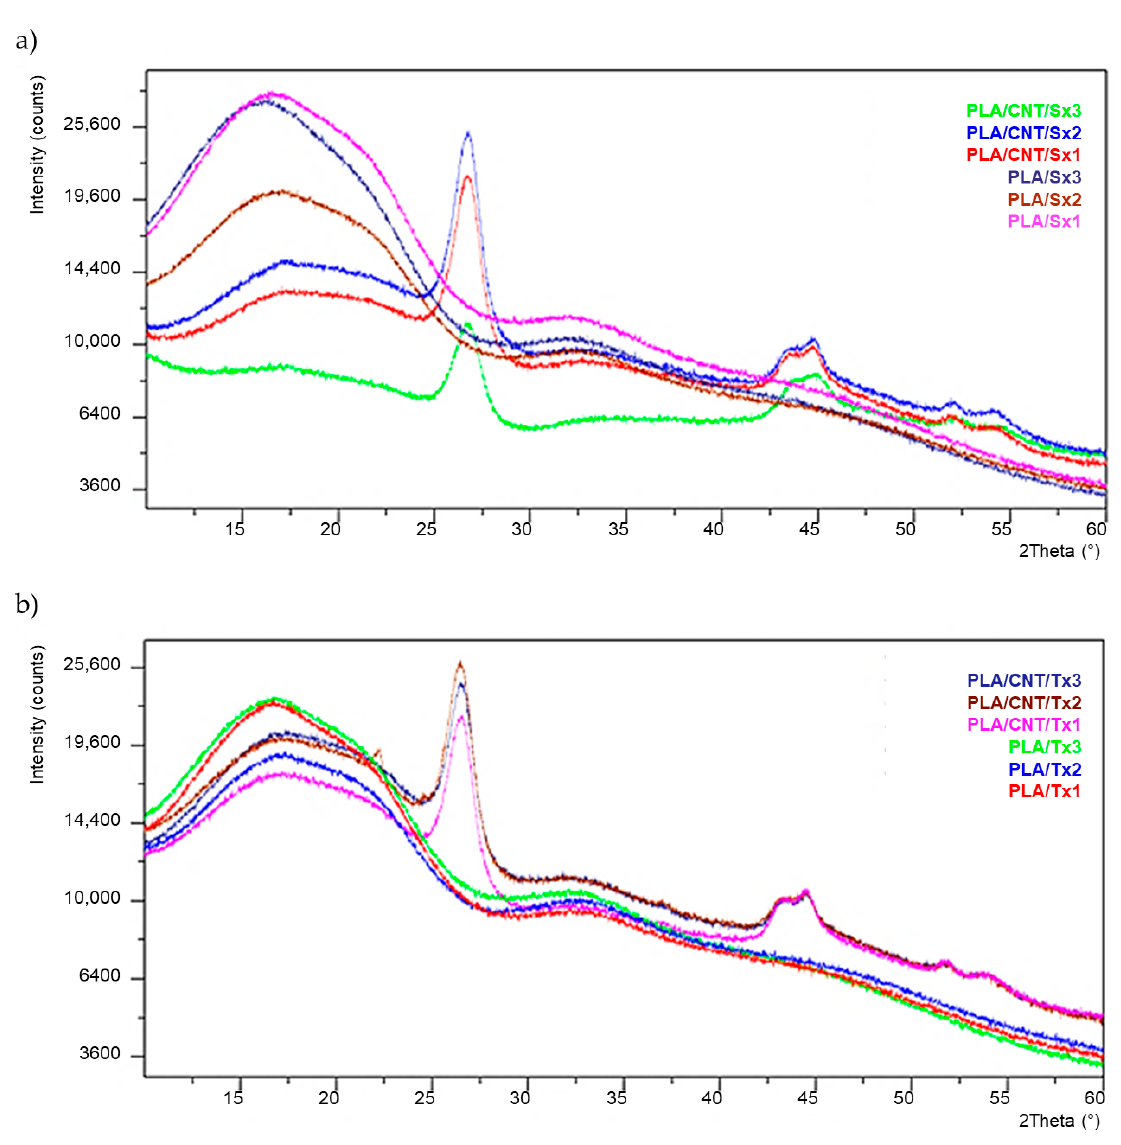
Figure 4. XRD patterns of neat PLA and PLA/CNT composites subjected to single ‒ screw extruding ( a ) and twin ‒ screw extruding ( b ). Table 6. XRD analysis results.